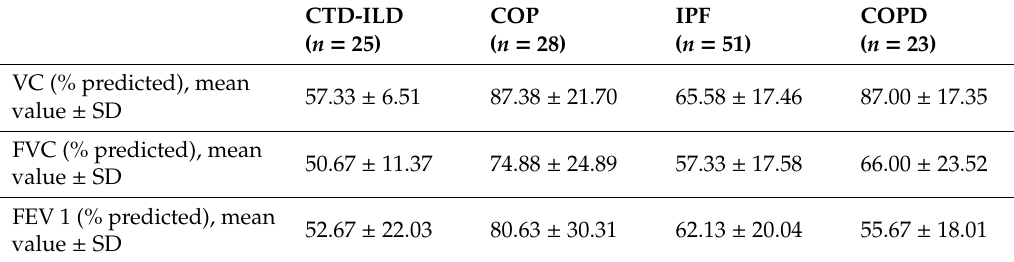
Table 3. The results of lung function and gas exchange data of CTD-ILD, COP, IPF, and COPD